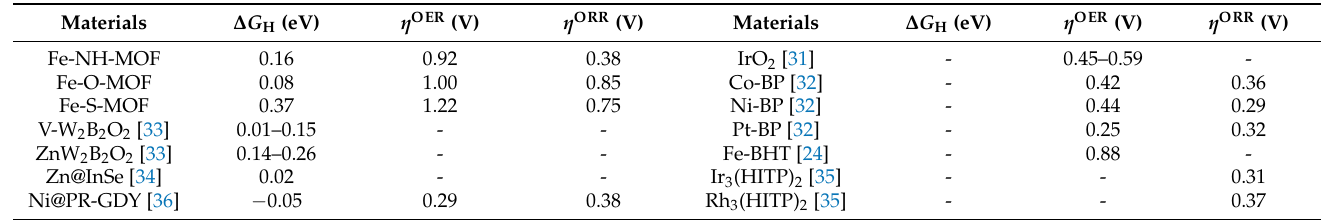
Table 2. Comparison of the HER ( ∆ G H , eV), OER ( η OER , V), and ORR ( η ORR , V) catalysis performance in our results with previous literatures.